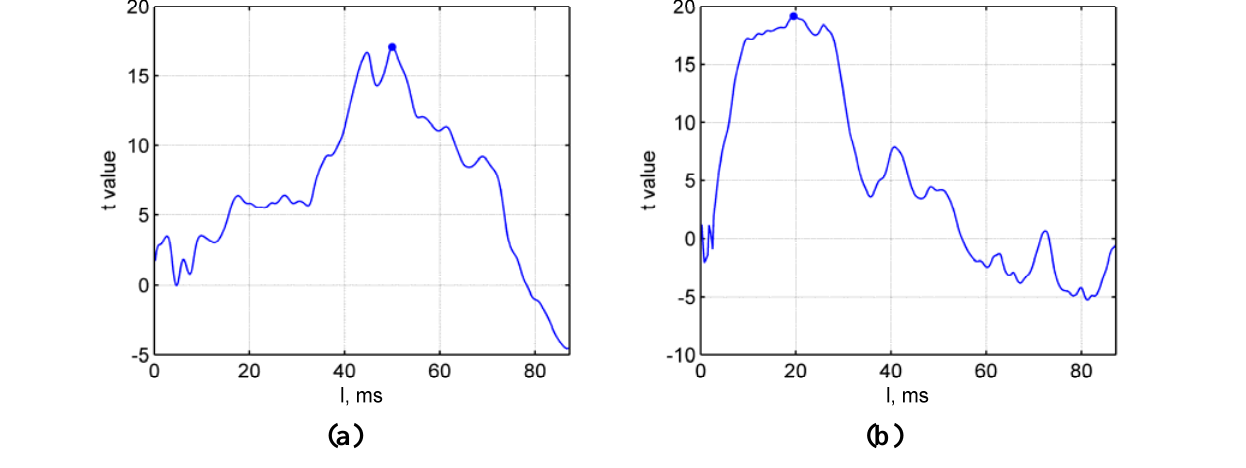
should be 50.2 ms; not 7. Figure 6, p. 1558 should be with the correct time axes. The PMC l optim should be 19.7 ms; not 78 ms: 200 ms. The VC l optim Figure 6. Optimal linear regression length. Experimental statistic (t-value) depends on the applied linear regression length and reveals an optimum duration, l , here shown in a optim typical example for ( a ) the PMC (blue dot; l = 50.2 ms, t = 17.0, p < 0.001) and ( b ) the optim VC condition (blue dot; l = 19.7 ms, t = 19.12, p < 0.001). Note that panels are optim scaled